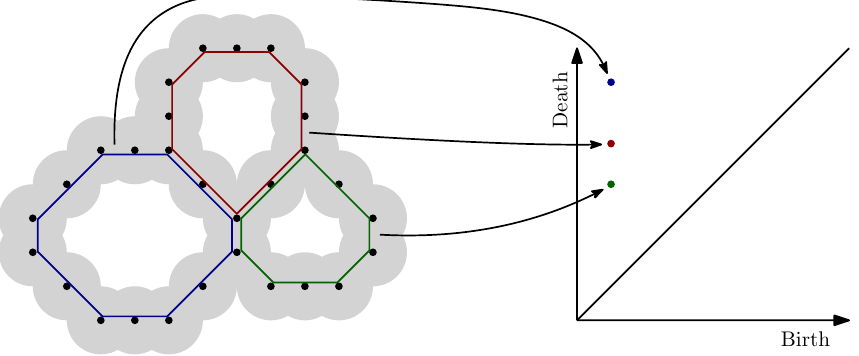
Figure 1. Schematic outlining point cloud to persistence diagram. (left) A point set (representing atomic centers) with balls of increasing radius around the points, (right) 1-dimensional persistence diagram of the point set. Representative cycles, corresponding to the points in the diagram, are highlighted with matching colors. The larger the loop, the higher the persistence value ( death − birth ). Figure created with Ipe 7.2.23 (http:// ipe. otfri ed.